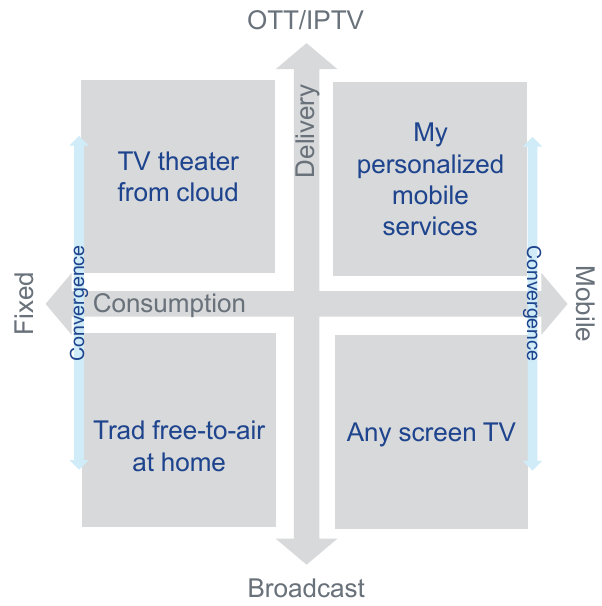
Figure 2. Scenarios for the UHF band media usage Technology scenarios